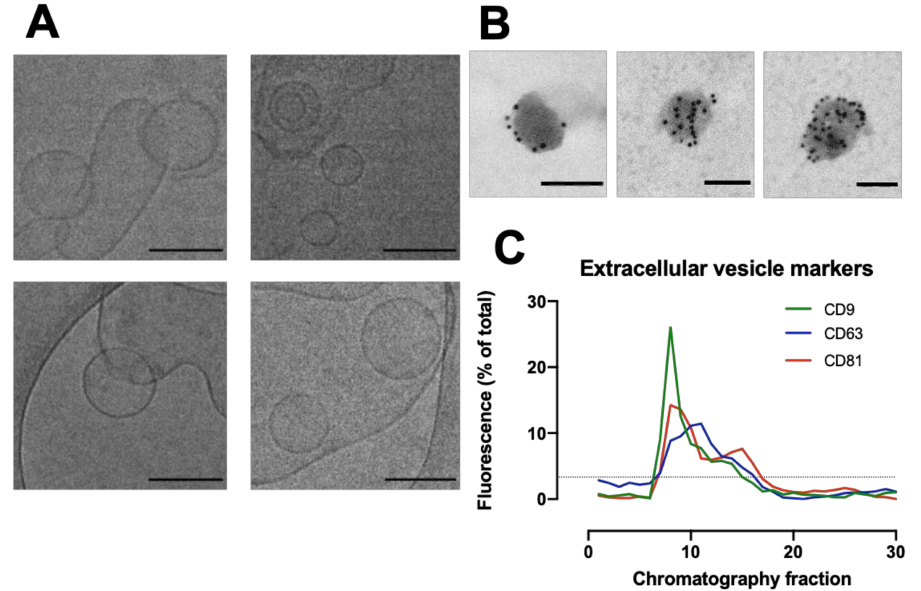
Figure 2. Characterisation of extracellular vesicles (EVs) from human cardiac fibroblasts. ( A ) Cryo- genic Transmission electron microscopy (cryo-TEM) of fibroblast-conditioned media. Scale bar = 100 nm. ( B ) Immunogold-electron microscopy tagging for CD63 identified lipophilic particles with high CD63 expression. Scale bar = 100 nm. ( C ) Quantification of dot blots of fibroblast-secreted EV samples against CD9, CD63 and CD81 as percentage of total signal. Dotted line represents mean (3.33). N = 2